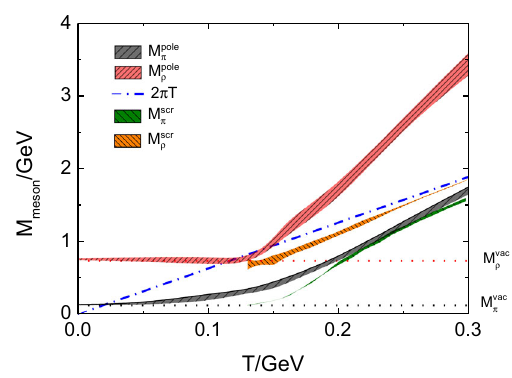
Fig. 1 The extrapolation for eigenvalue of pion BSE at T = 150 MeV with Λ = 1 GeV. The pole mass is obtained at the location λ( P 2 − M 2 ) = 1 pole